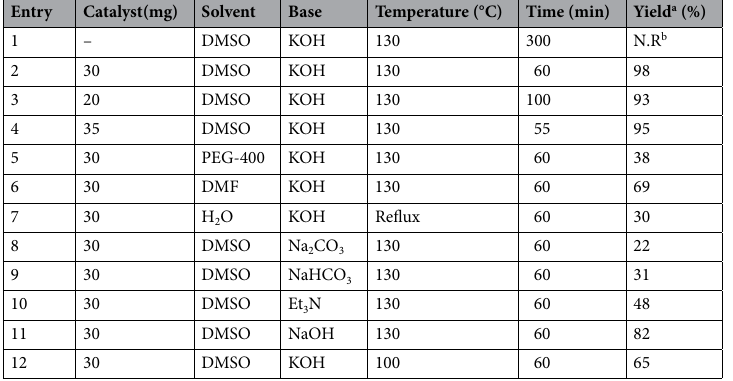
Table 4. Optimizing conditions for the synthesis of diaryl ether using Cu(II)-MP-bis(AMP)@boehmite. a Isolated yield. b No reaction.